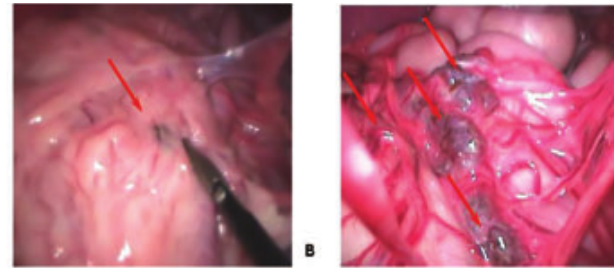
FIGURE 3 - Images from the video records made during the diagnostic laparoscopy of 5-spleen-chip autotransplanted animal ( A ), 10-spleen-chip autotransplanted animal ( B ) in the postoperative 12 th month. The arrows show to the spleen autotransplants.